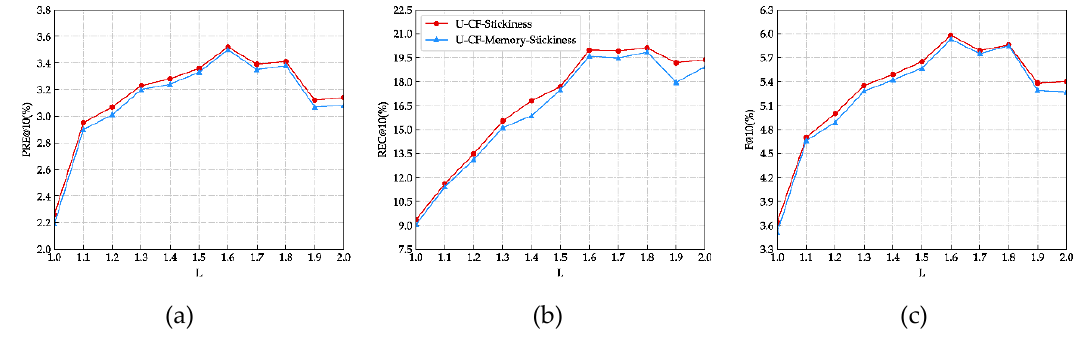
Figure 5. Recommendation performance under different values of the POI stickiness threshold L (at a rank cut-off value of N = 10). ( a ) Precision with different L values. ( b ) Recall with different L values. ( c ) F-value with different L